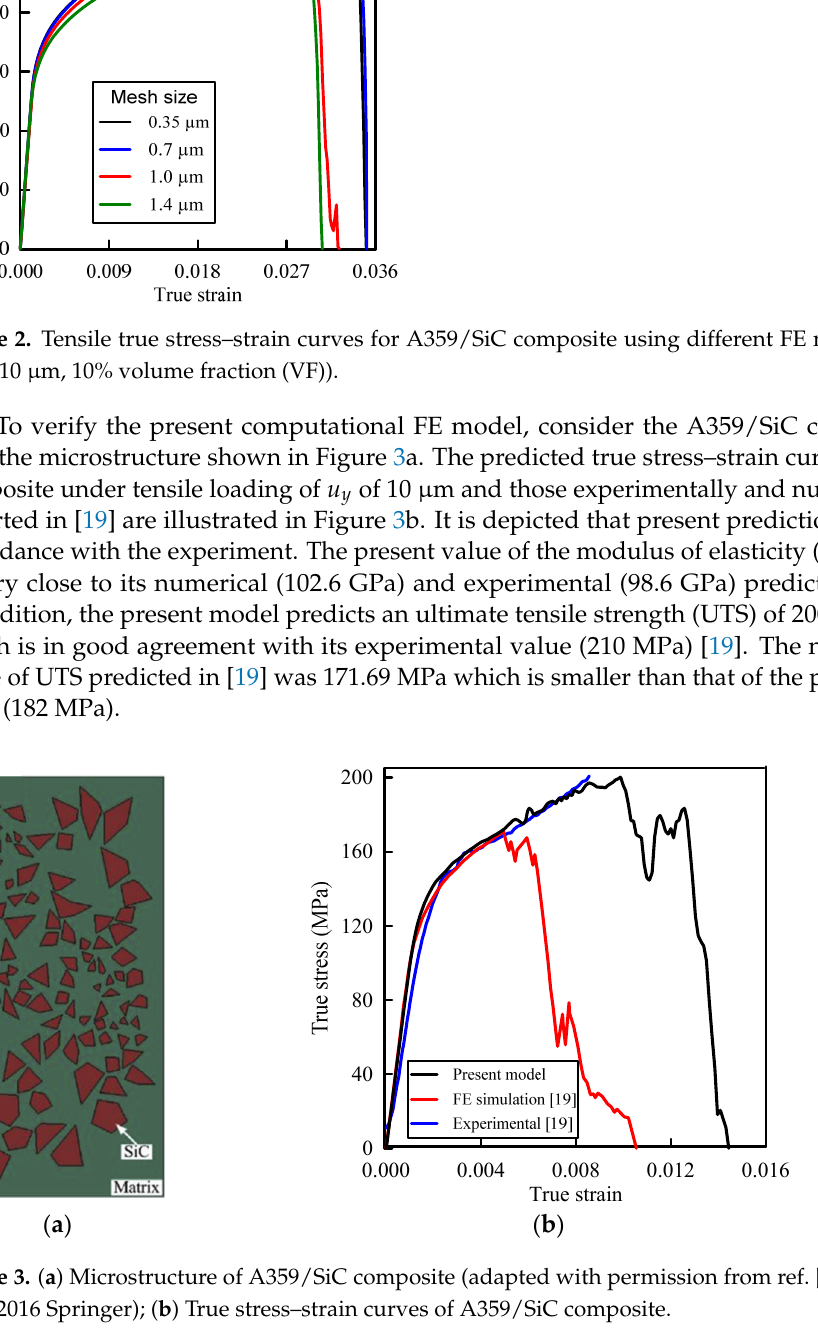
Figure 3. ( a ) Microstructure of A359/SiC composite [19]; ( b ) True stress–strain curves of A359/SiC composite.